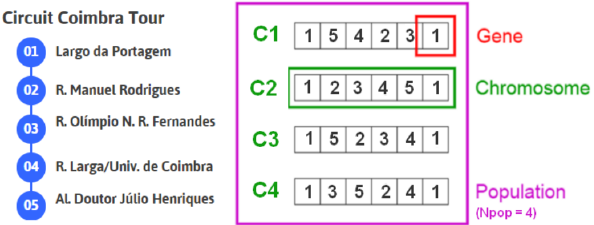
Figure 7. Example of a population of the genetic algorithm, for the problem of visiting five different places. The population contains four individuals, each individual consisting of five genes—one for each